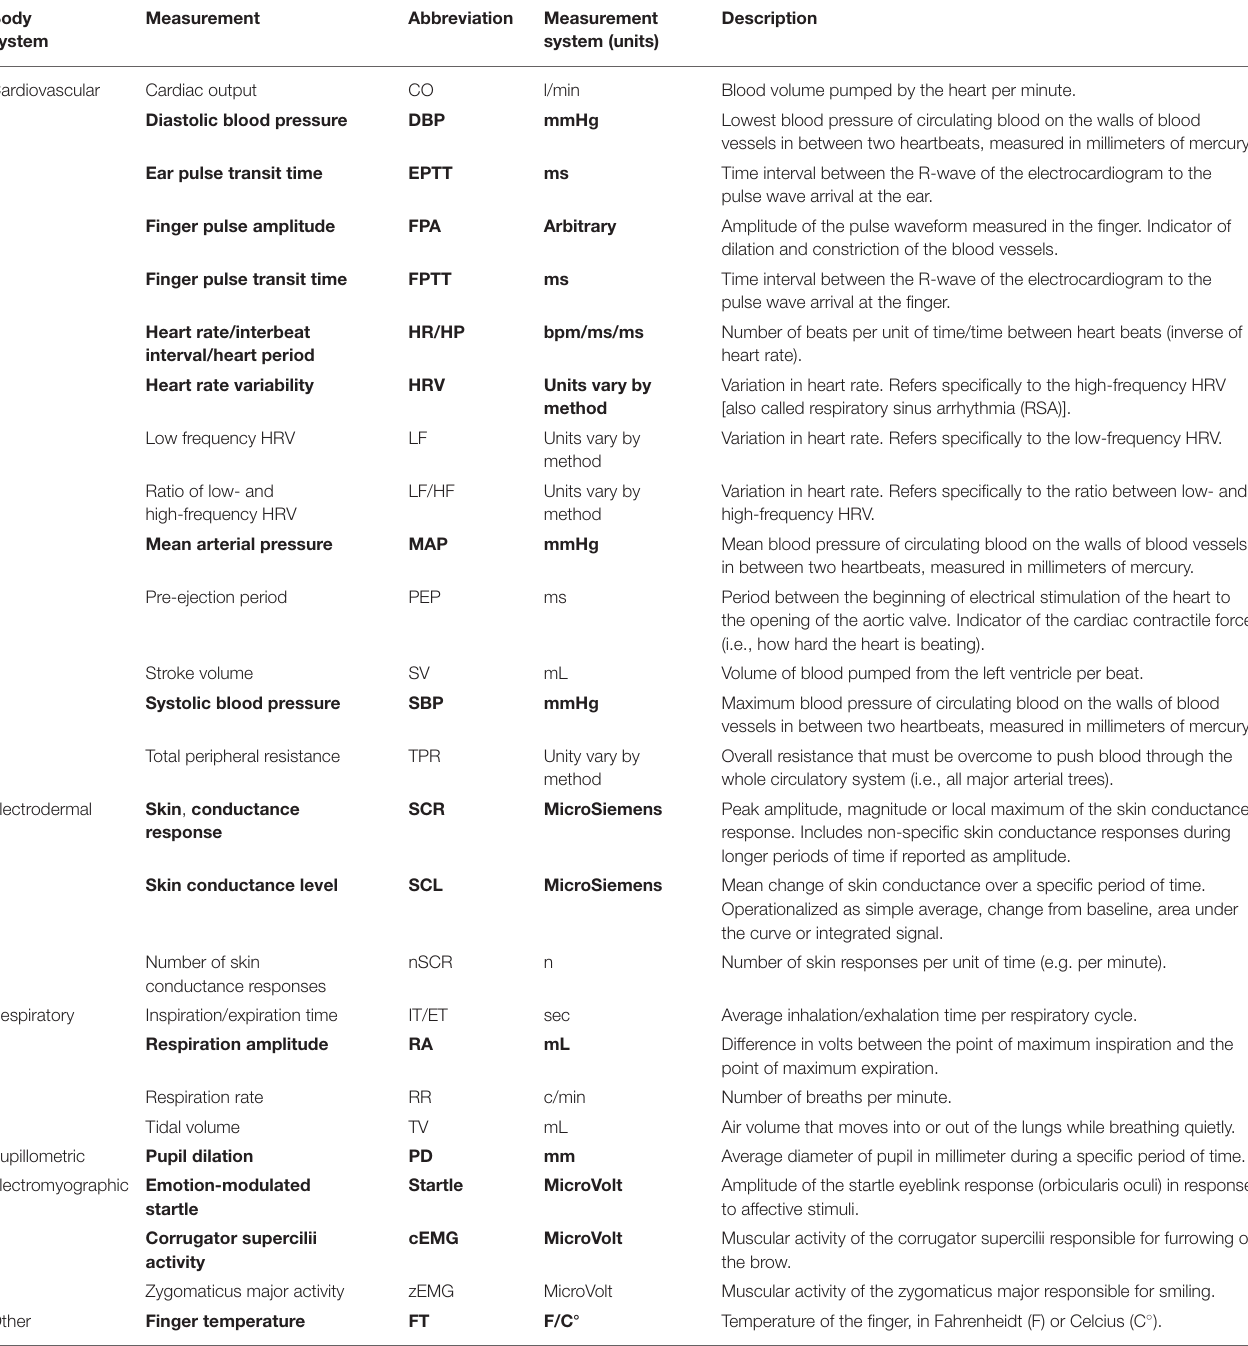
TABLE 2 | Common psychophysiological measures of emotion regulation studies. Body